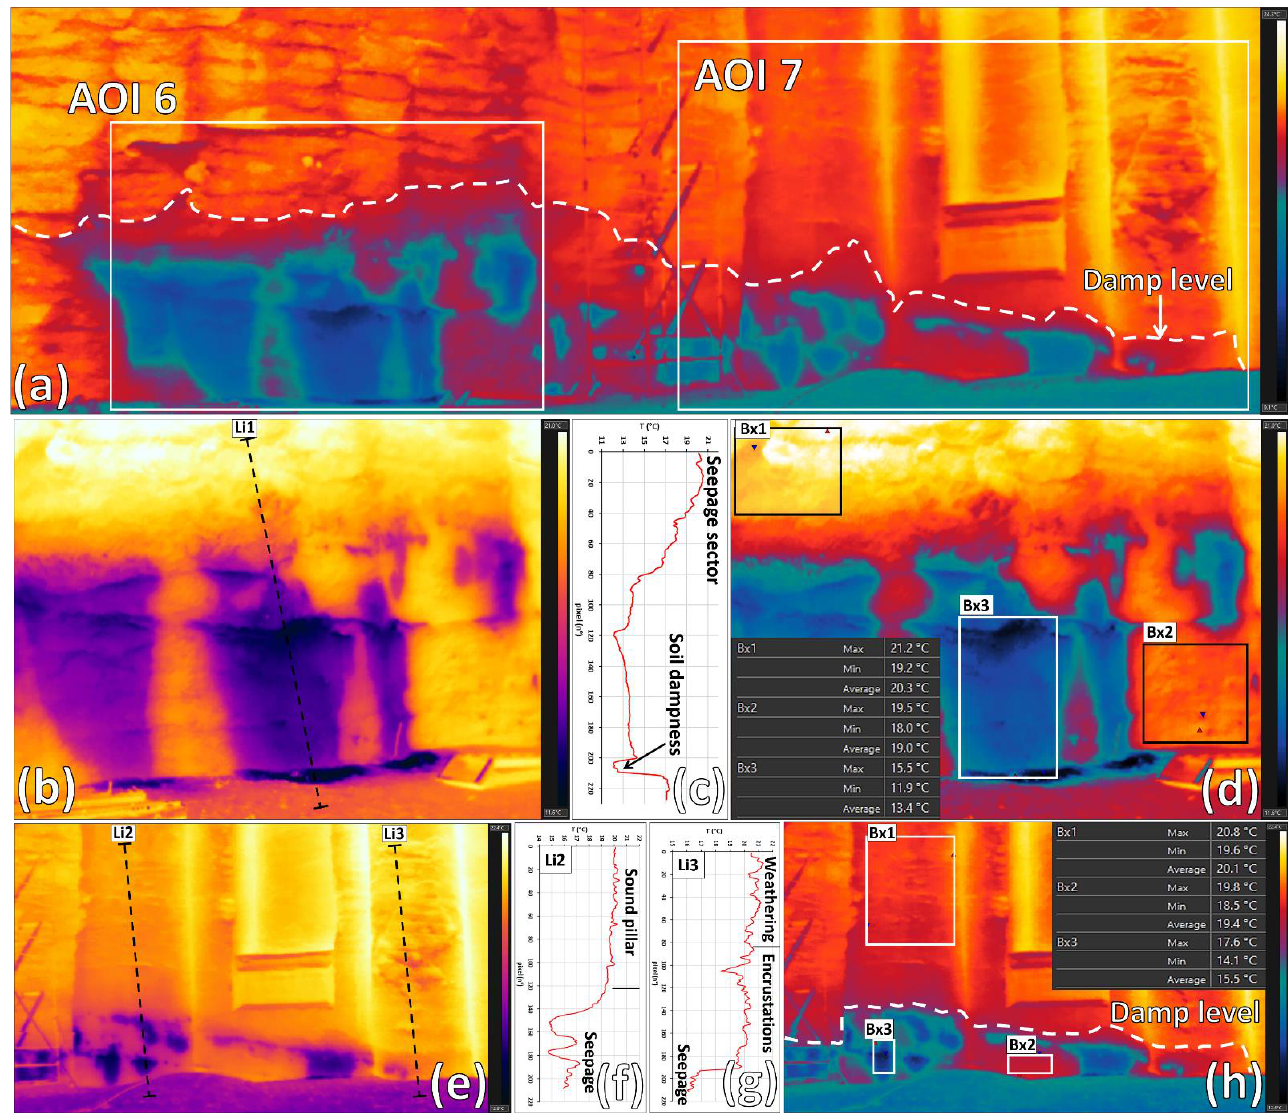
Figure 17. Petra Monastery IRT data: mosaicked thermal image of the low-left corner of the monastery (680 × 240 pixels; corresponding optical image in Figure 5c) ( a ); close-up single thermograms (320 × 240 pixels): AOI 5 ( b – d ) and AOI 6 ( e – h ).